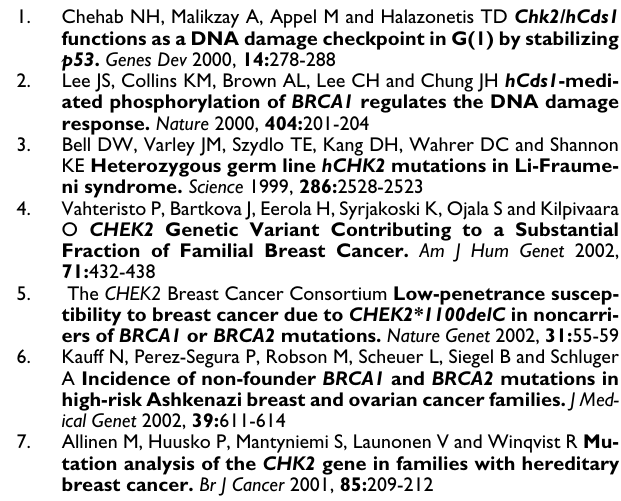
BRCA1/2 -negative individuals of mixed ethnicity with breast cancer from families with 3 or more cases of breast cancer BRCA1/2 Ashkenazi founder mutation-negative individuals with breast cancer from families with 3 or more cases of breast cancer BRCA2 -negative i individuals of mixed ethnicity with male breast